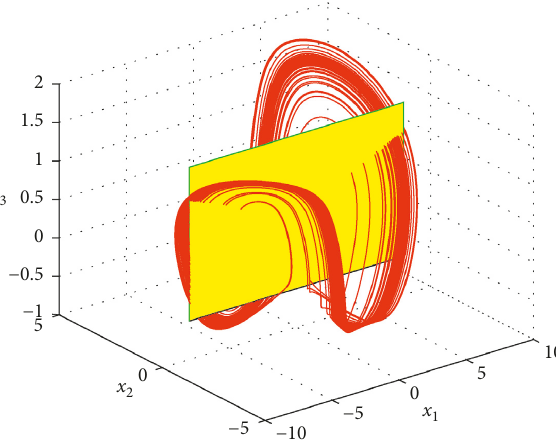
Figure 6: Poincar´e cross section of the proposed